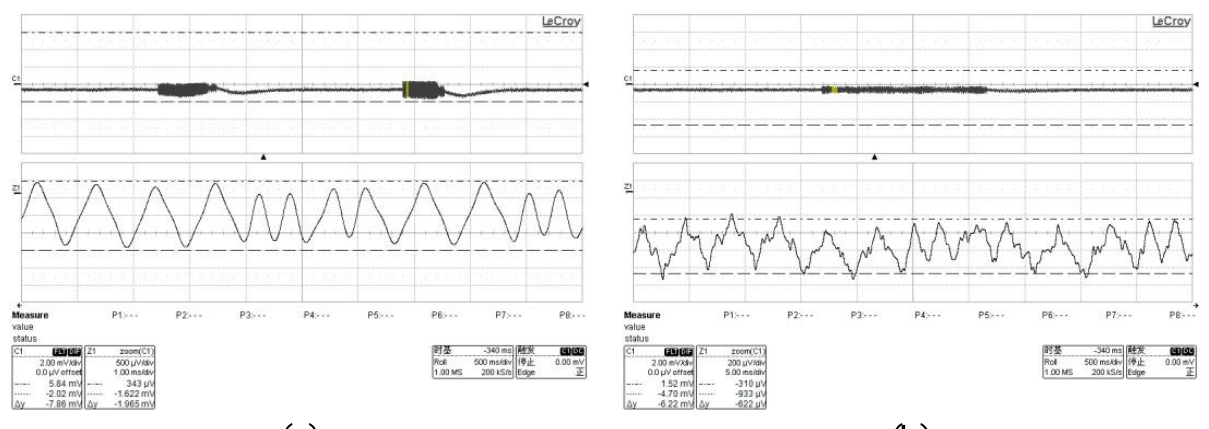
Figure 14. ( a ) The sensed signals of fast swiping. ( b ) The sensed signals of slow